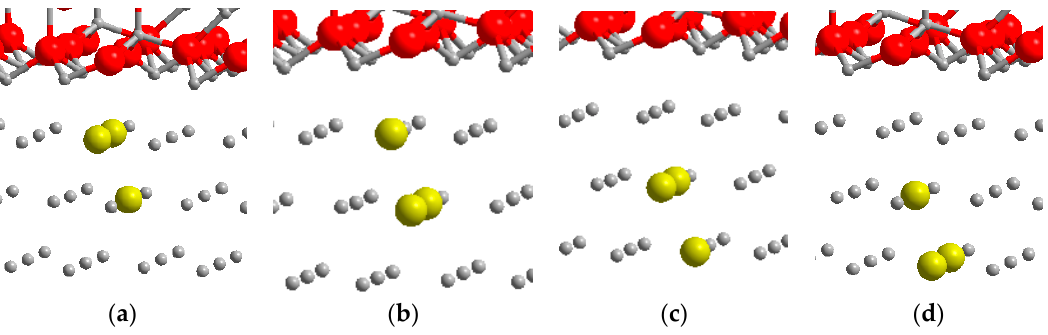
Figure 7. Models of GP1 zone considered. ( a ) Configuration 1 and position 1; ( b ) configuration 2 and position 1; ( c ) configuration 1 and position 2; ( d ) configuration 2 and position 2.